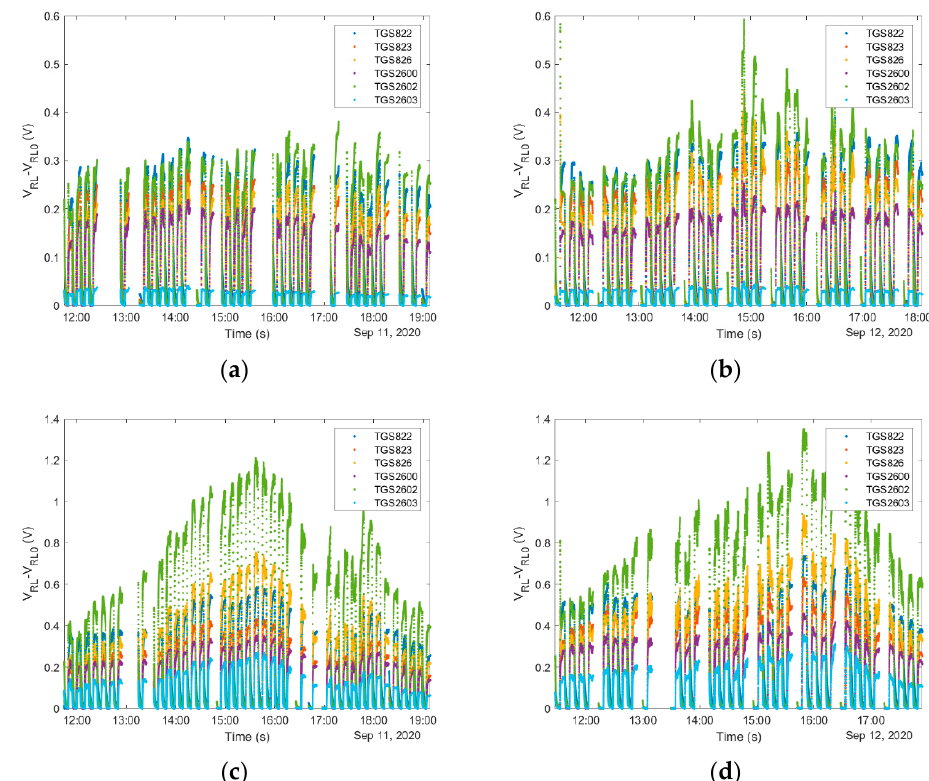
Figure 6. Results of monitoring two bee colonies, living in one apiary, in adjacent beehives during two consecutive days. ( a ) Bee colony 1 on day 1; ( b ) bee colony 1 on day 2; ( c ) bee colony 2 on day 1; ( d ) bee colony 2 on day 2.